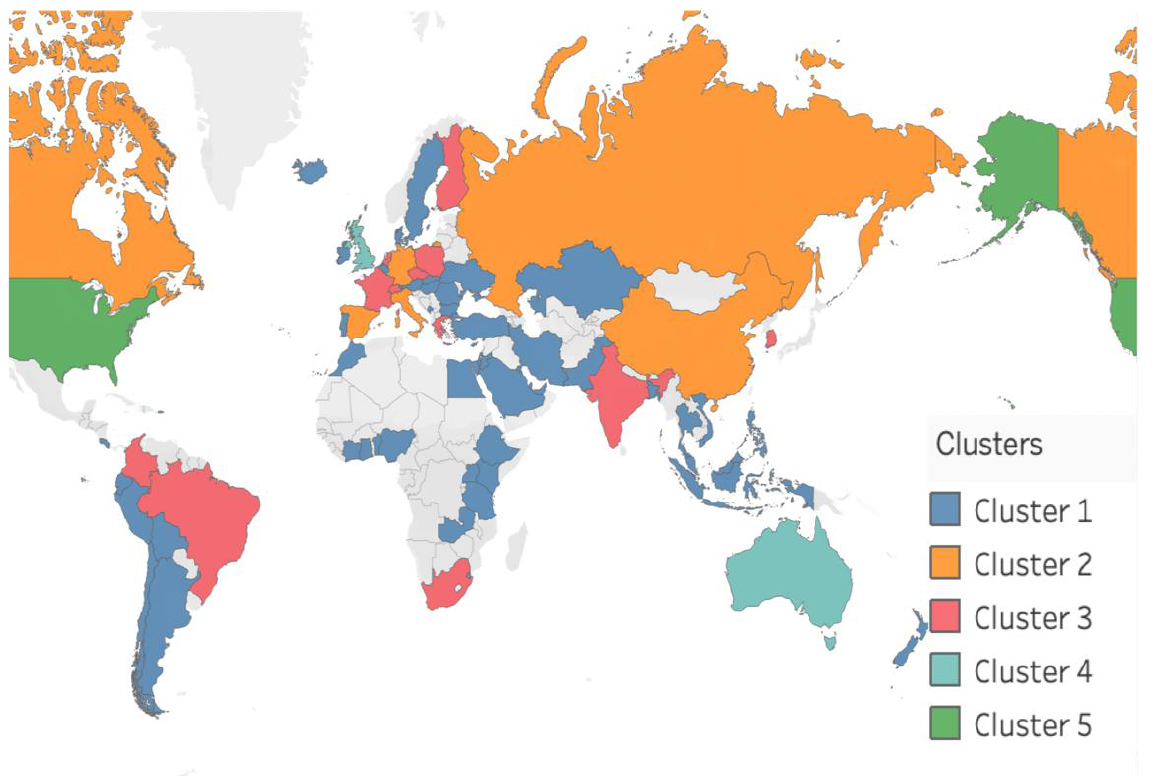
Figure 2. Country analysis. Source: Authors’ selection from the WoS database, based on selected words, using the Tableau program.